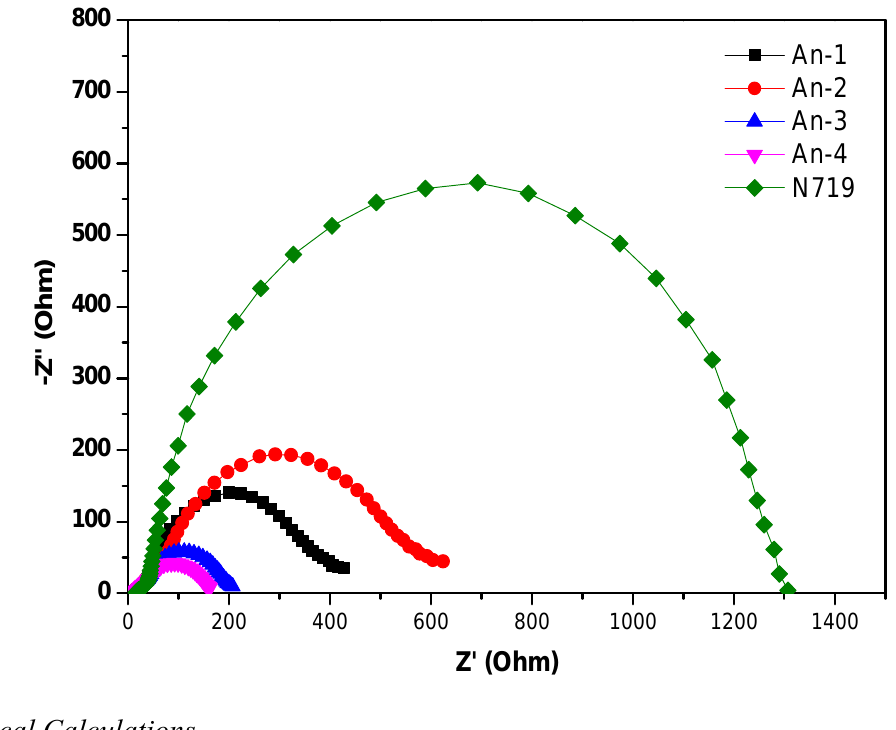
Figure 8. Electrochemical impedance spectra (Nyquist plots) of DSSC for dyes measured in the dark under − 0.55 V